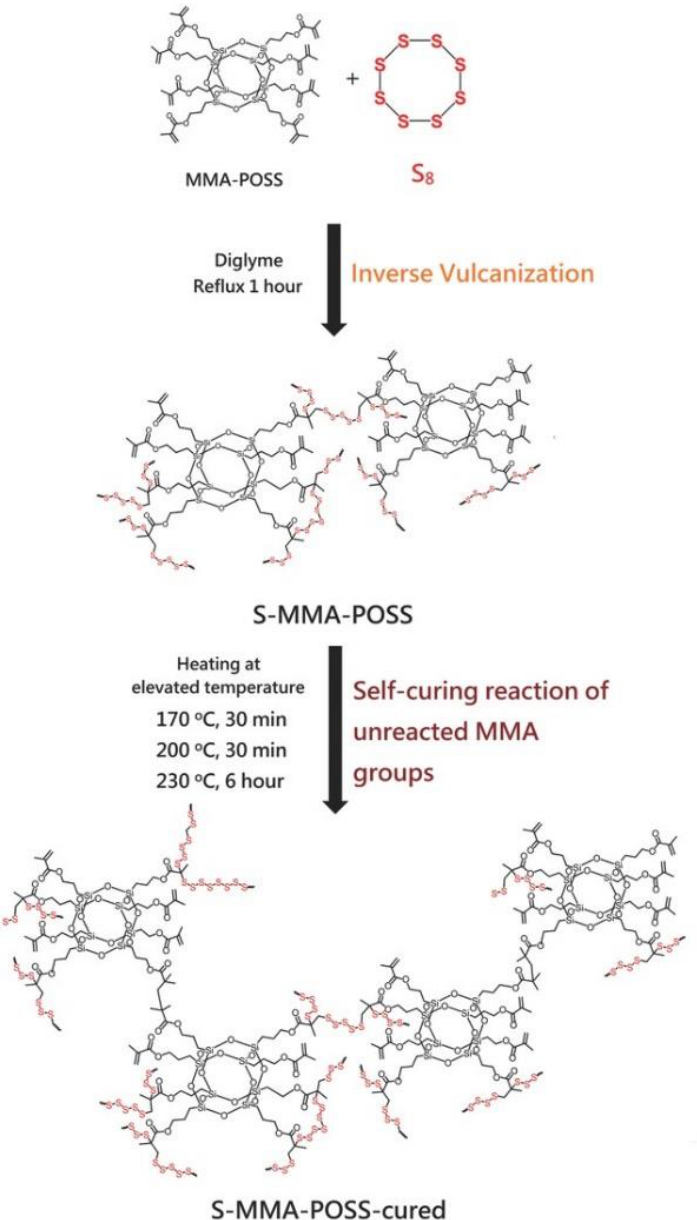
Figure 24. Synthetic routes for preparation of reactive hybrid S-MMA-POSS. Copyright (2017) Wiley. Used with permission from (Lin, H.-K.; Liu, Y.-L., Reactive Hybrid of Polyhedral Oligomeric Silsesquioxane (POSS) and Sulfur as a Building Block for Self-Healing Materials, Macromol. Rapid Commun . 2017, 38 , 1700051; WILEY-VCH Verlag GmbH & Co. KGaA, Weinheim) [85].